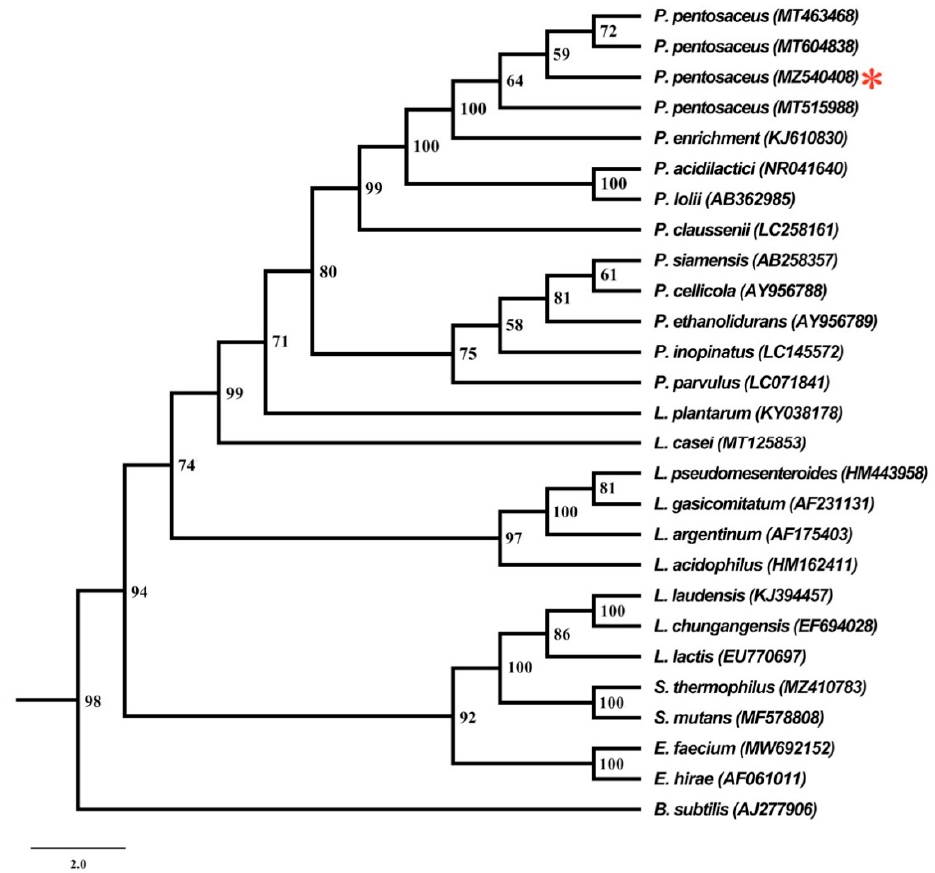
Figure 1. Phylogenetic tree representing the evolutionary relationship of P. pentosaceus with other strains from the NCBI database. * denotes our isolated strain P. pentosaceus . strains from the NCBI database. * denotes our isolated strain P. pentosaceus